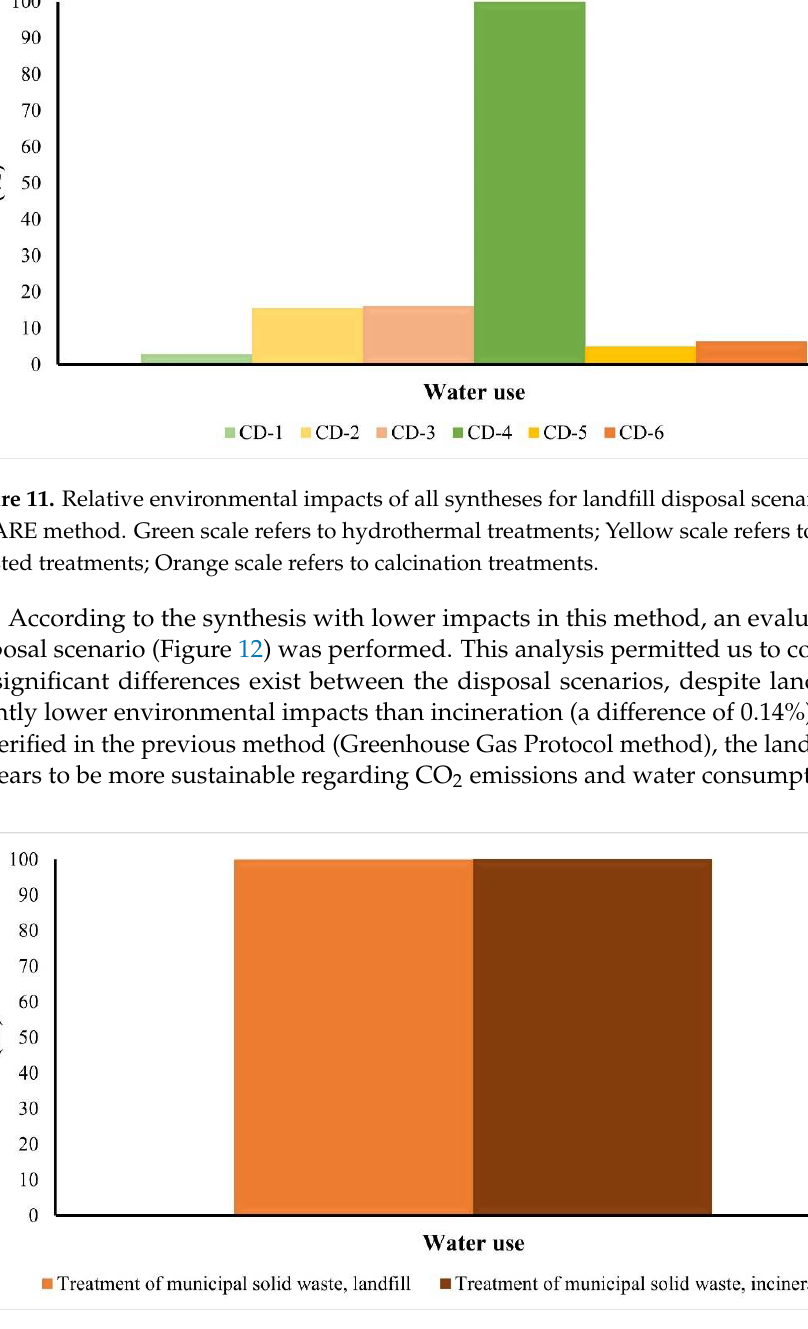
Figure 10. Relative environmental impacts of all the syntheses under study for incineration disposal scenario, applying AWARE method. Green scale refers to hydrothermal treatments; Yellow scale refers to microwave-assisted treatments; Orange scale refers to calcination treatments.